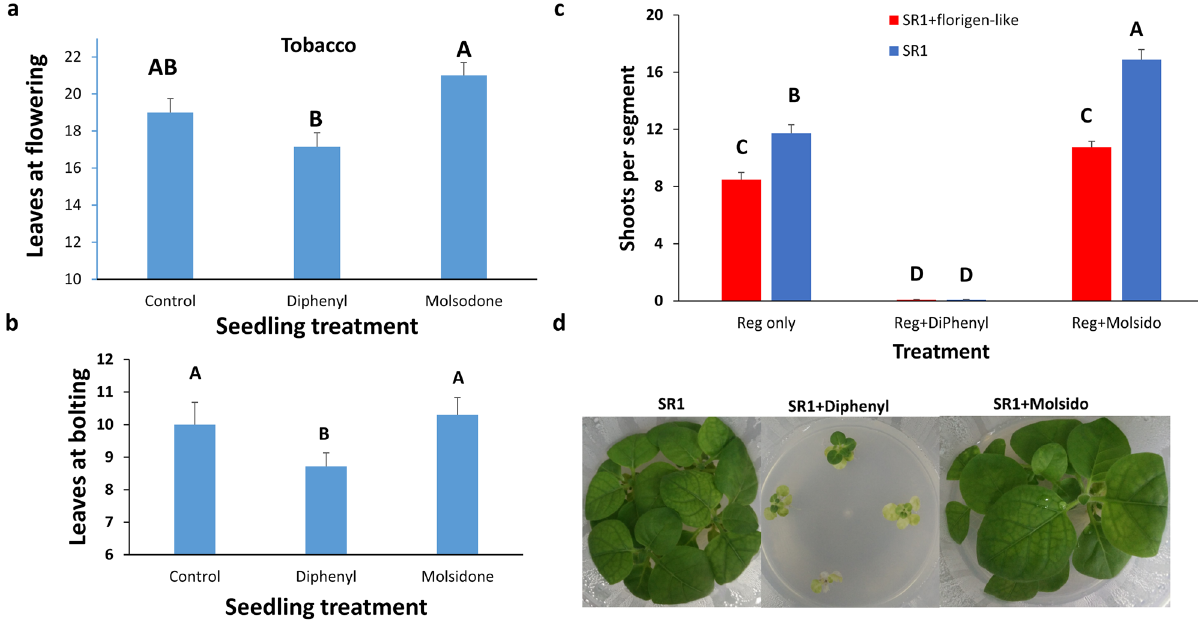
Figure 2. Effect of Nitric Oxide donor or inhibitor on flowering and shoot regeneration. ( a ) Tobacco seedlings at the cotyledon stage were transferred and grown on an agar medium supplemented with 2% sucrose and 5 µM DiPhenyl or 5 µM Molsido. At the seven-leaf stage, seedlings were transferred to soil and grown to flower. The number of leaves at the time flower buds emerged ± SE was counted for tobacco plants, each treated with DiPhenyl or Molsido and control. The experiment was done in 2 replicates with 5–7 plants each. ( b ) Arabidopsis seedlings at the cotyledon stage were grown on agar medium supplemented with 2% sucrose and 5 µM DiPhenyl or 5 µM Molsido. At a six-leaf stage, seedlings were transferred to soil and grown to flower. The number of leaves at the time flower buds emerged ± SE was counted, each treated with DiPhenyl or Molsido and control. ( c ) The effect of Nitric Oxide donor ( Reg + Molsido ) or inhibitor ( Reg + DiPhenyl ) on the number of shoots ± SE regenerated after 30 days on juvenile leaves segments from non-transformed plants ( SR1 ); plants transformed with a 35S::florigen-like gene from avocado ( SR1 + florigen ). The experiment was done in 3 replicates, and each had 20–25 leaf segments. Statistical analysis was conducted among each color group using the JMP program and Tukey analysis. Different letters depict statistically significant differences between treatments (p{f} < 0.001). ( d ) Tobacco seedlings treated with 5 µM DiPhenyl or 5 µM Molsido or none before transfer to soil. The seedlings were transferred to 2% sucrose only or 2% sucrose + 5 µM DiPhenyl or 2% sucrose + 5 µM Molsido agar at the cotyledon stage. All plants recovered from the expressed in tobacco or Arabidopsis 21,22 . However, while FT1, the florigen expression in perennial plant’s expres- sion, precedes flowering, the FT2 or the rejuvenator expression is during the vegetative period 21,23 . Thus, florigen and a rejuvenator are both homologs to the A. thaliana gene FLOWERING LOCUS T ( AtFT1 ) gene, coordinating the repeated cycles of vegetative and reproductive growth in woody perennial like poplar 24 (Populus spp.) or pear 21 by cycling expression year-round. Florigen action in the meristem to induce flowering 27,32 functions to transform the leaf into a mature organ changing its shape 33 and reducing its capacity to regenerate. While the phase change from vegetative to reproductive growth in a plant is accompanied by changing leaf shape 33 , we found that inducing early flowering and reducing regeneration ability is not related to this shape change. While the shape changes are correlated with reduced mir156 and increased SPL genes 33 , this study shows that indepen- dently from flowering and other meristematic effects, FT genes function in the leaf tissue as a determinant of juvenility or maturity depending if the rejuvenator or the florigen is expressed without changing the leaf shape that is typical of plant maturity. Examining FT’s immediate suspects in meristematic flowering processes did not reveal an expression pattern that is similar to FT mRNA (Table S1 and S2). Thirteen FT-like genes were identi- fied in tobacco 34 ; out of these 13 genes, NtFT4 and NtFT5 were shown to function as florigen 35,36 . RNA–seq of leaf tissue from mature or juvenile leaves showed that NtFT4 is expressed in mature leaves and not in juvenile leaves, while NtFT5 is not expressed in the leaves. Treating the tobacco leaves with NO modifiers that promoted flowering and inhibited regeneration increased NtFT4 but did not affect the expression of NtFT5 (remained zero). Treatment of tobacco leaves with NO modifiers that inhibited flowering and enhanced regeneration and depressed NtFT4 expression, NtFT5 expression was zero. We, therefore, conclude that there are tissue-specific flo- rigen in tobacco and maybe other plants. Some florigen genes are expressed in the leaves, and some in the stem 35 . NO (Nitric Oxide) levels are involved in flowering, as demonstrated in Oncidium’s 25 and Arabidopsis 37 . Appli- cation of NO donor on Arabidopsis vtc 1 mutant caused late flowering, and the expression levels of flowering- associated genes ( AtCO , AtFT , and AtLFY ) were reduced, suggesting NO signaling is part of flowering 25,26 . Reducing the amount of NO in Arabidopsis plants promoted flowering, increasing NO inhibited flowering 37 , as was shown here. In parallel, reducing the amount of NO decreases regeneration, and increasing the amount of